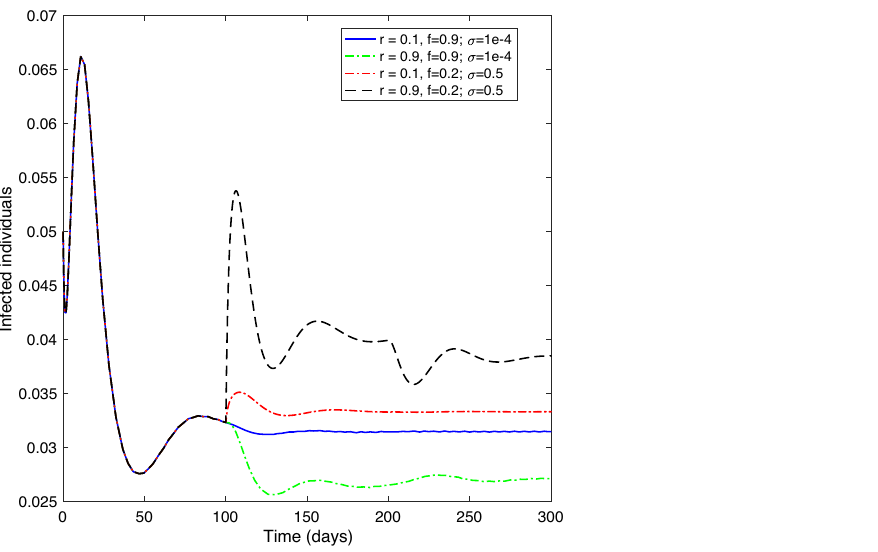
Figure 8. The effect of r , f and σ on the infected class of system